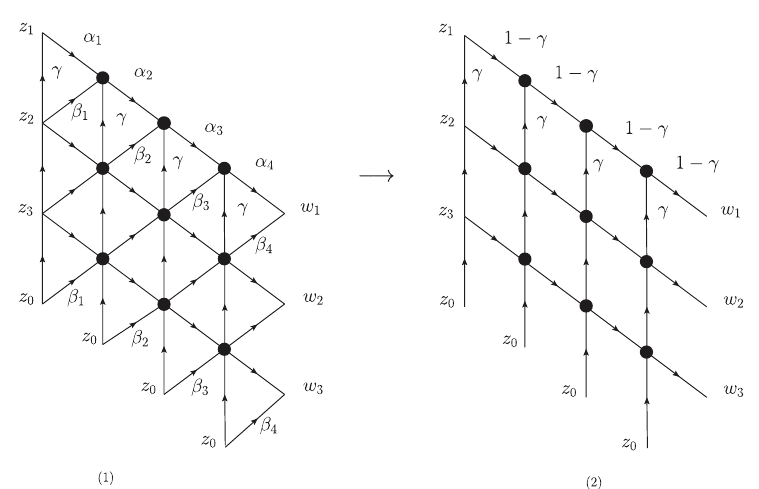
Figure 7 . (1) The diagram for (cid:3) 3 ( y 1 (cid:13) = 2 s